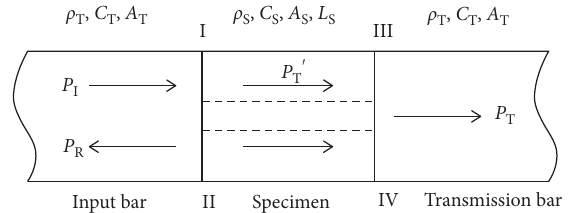
Figure 2: Transmission and reflection of the one-dimensional longitudinal wave in the